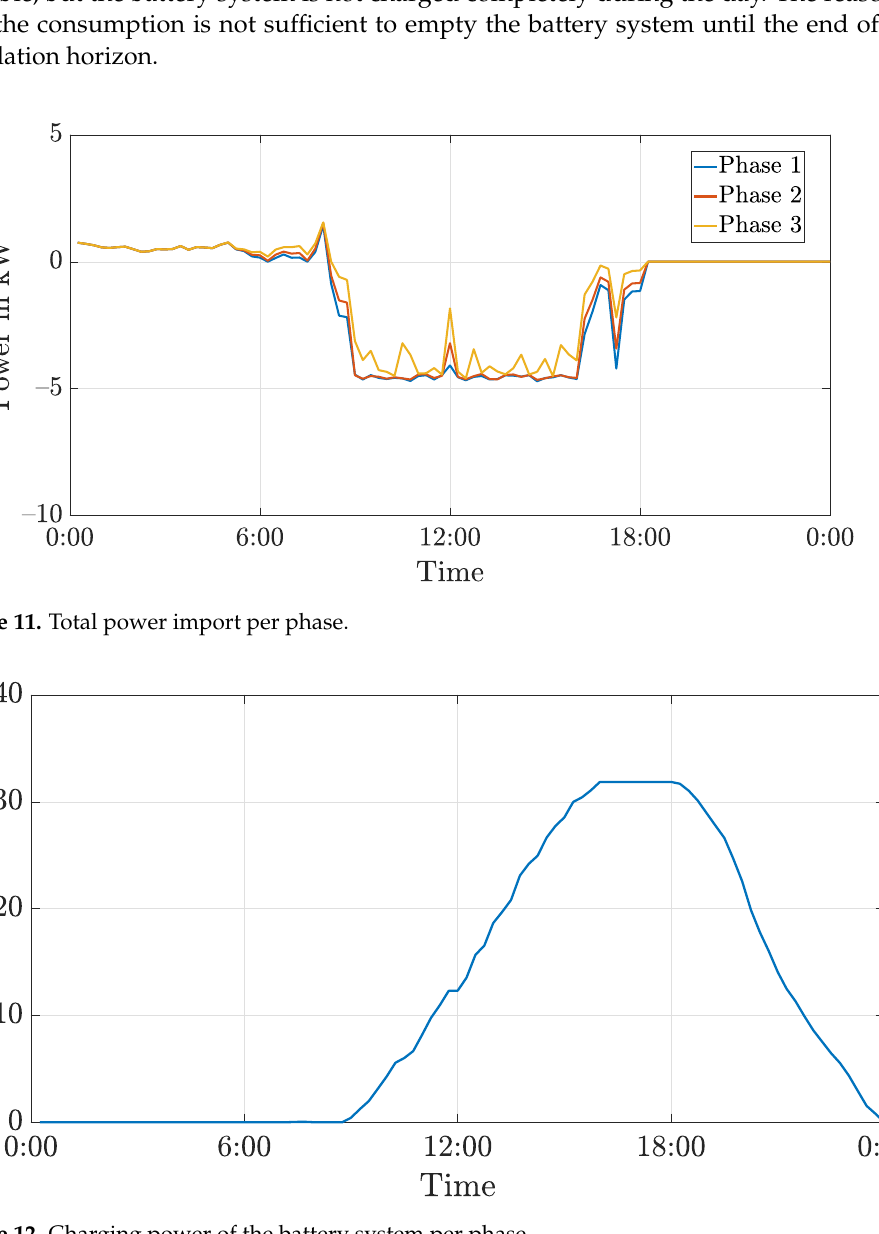
Figure 12. Charging power of the battery system per